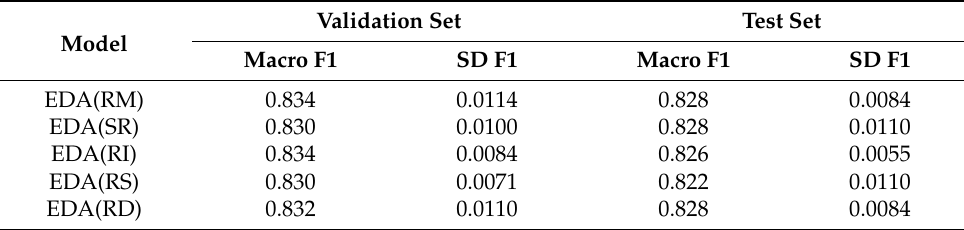
Table 5. Classification performances of different EDA methods in five-fold cross validation.